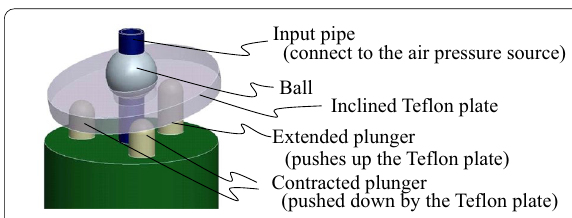
Fig. 3 Inclined plate to restrict the motion of the plungers